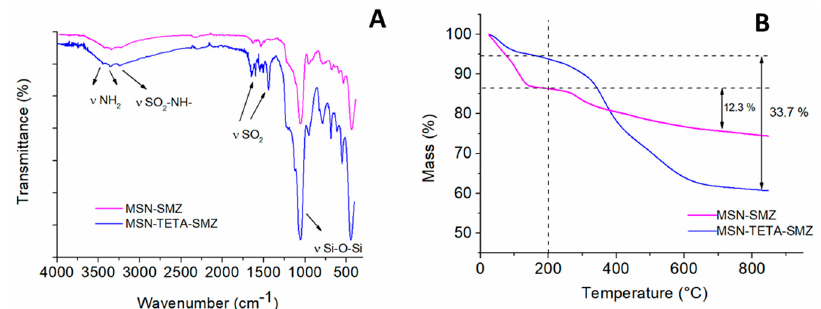
Figure 4. ( A ) FT-IR spectra ( B ) TGA of MSN-SMZ and MSN-TETA-SMZ.